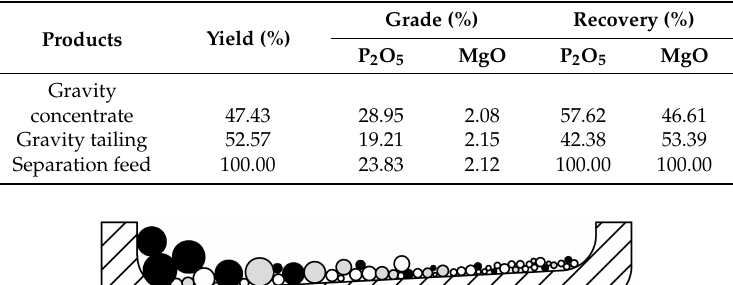
Table 4. Gravity separation results.